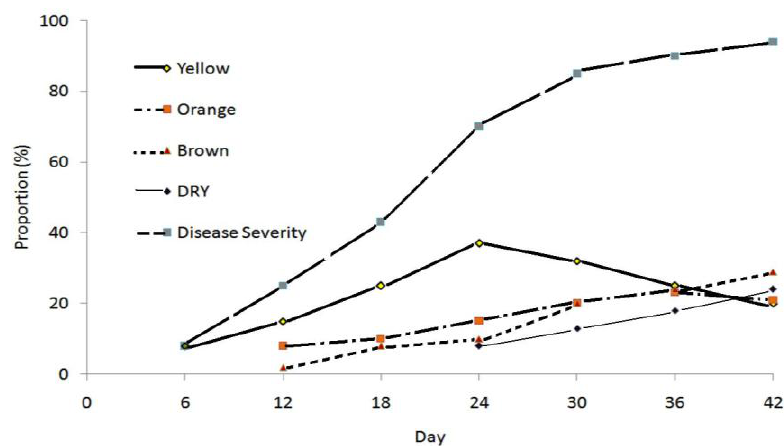
Figure 4. Proportion ofdisease severity and different disease symptomsin wheat flag leaf infected by Pucciniatriticina fromday 7 to 42 after inoculation